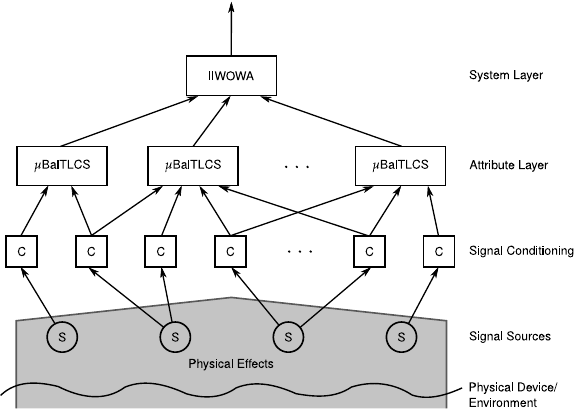
Figure 2. Multilayer attribute-based conflict-reducing observation system MACRO (Mönks and Lohweg,